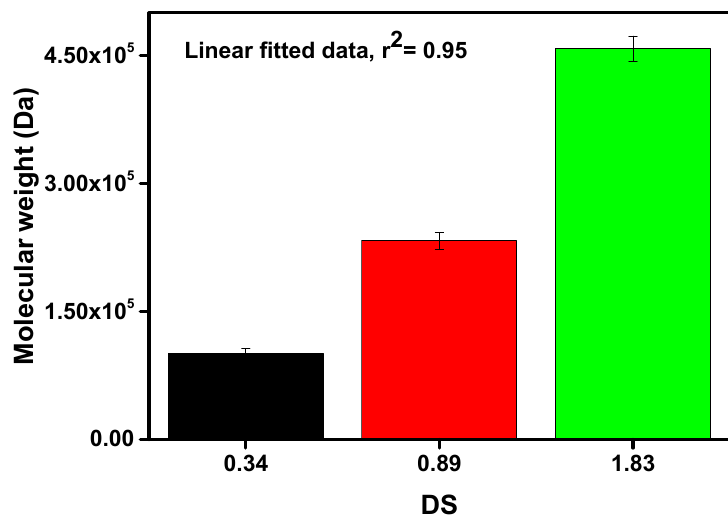
Figure 4. Estimation of molecular weight of prepared carboxymethyl cellulose (CMC) with di ff erent degrees of substitution value.